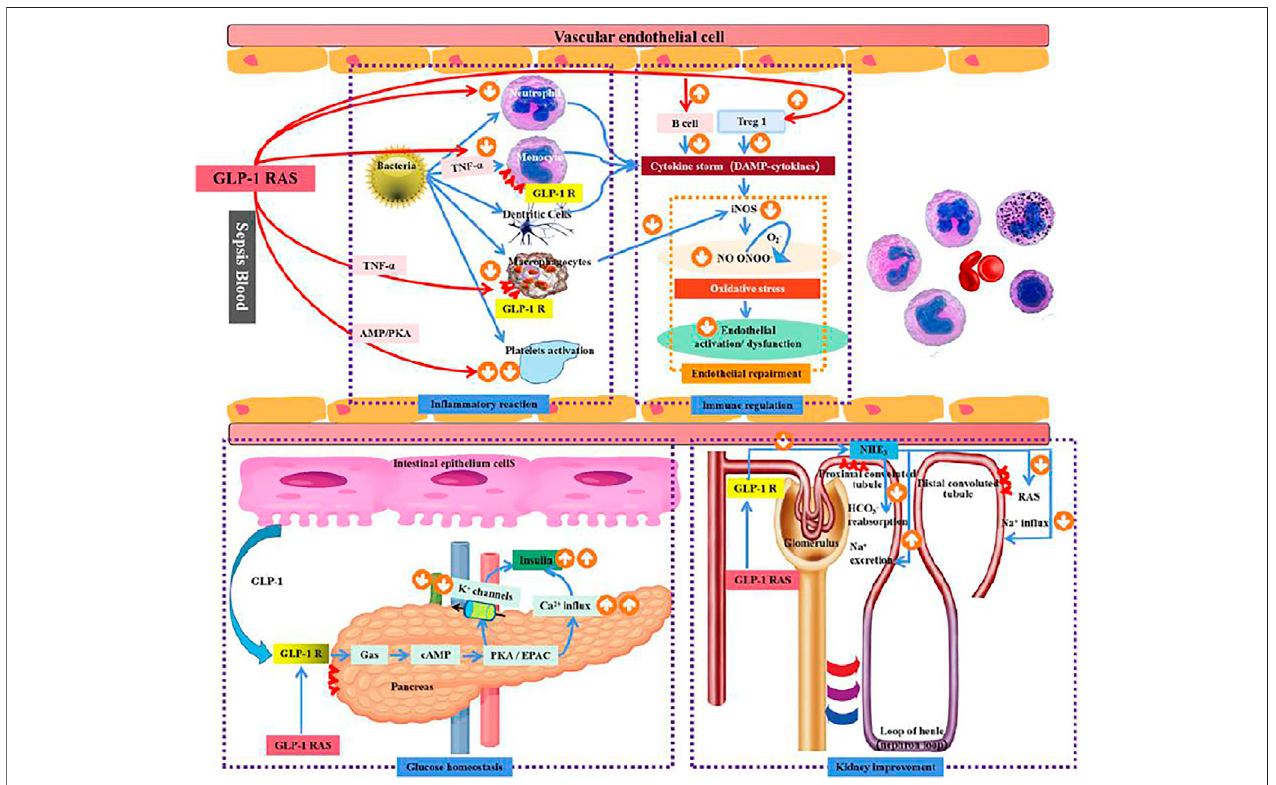
FIGURE 1 | Mechanism of GLP-1R in